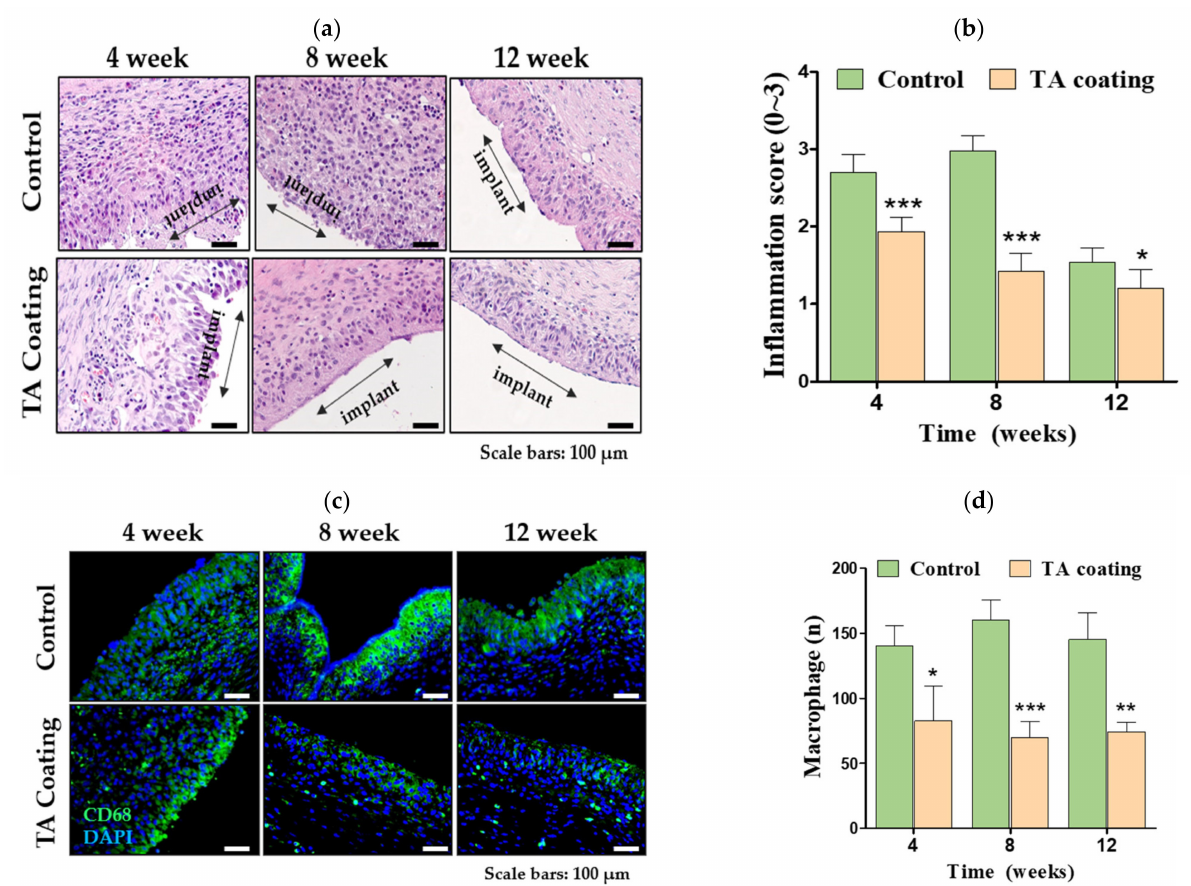
Figure 4. Inflammatory response to TA-coated and uncoated (i.e., control group) silicone breast implants. ( a ) Representative H&E images of the tissues at four, eight, and 12 weeks after implantation; the black double arrow shows the location of the implanted sample. Scale bars = 100 µ m. ( b ) Profiles of the degree of inflammation in the capsule tissue in TA-coated and uncoated silicone breast implants ( c ) Representative image of CD68 (green) in capsule tissues obtained from the control and TA groups. Nuclei were co-stained with DAPI (blue). CD68-positive macrophages were detected using a fluorescence microscope. Scale bars = 100 µ m ( d ) (d) Quantification of FITC-positive CD68-expressing cells from the control and TA groups. Data are represented as the mean ± SEM. * p < 0.05, ** p < 0.01, and *** p < 0.001 compared with the control